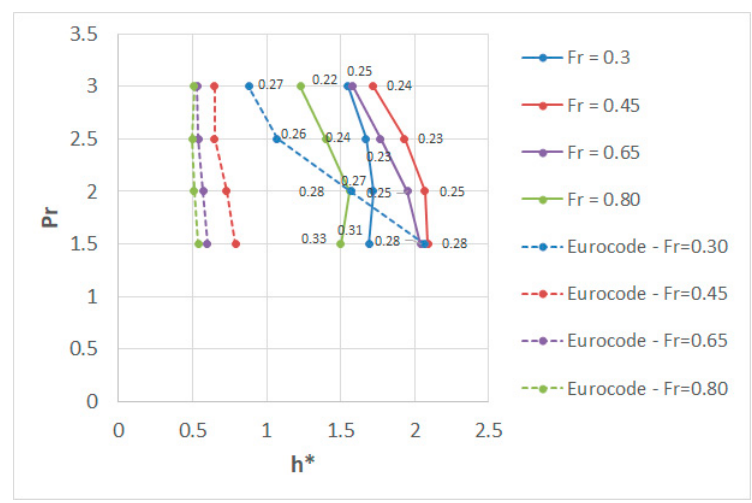
Figure 24. Comparison of contour lines of the threshold of deck failure between the Eurocode (C D = 1.44) [5] and this research for a box deck. Numbers on the figure demonstrate the blockage ratio (Br) for each failure point. To the right of each line is the unstable region, and the stable region is to the left. These stability curves hold for a comcrete box girder with a 48% void ratio, an aspect ratio (height:width) of 0.27, and a bearing friction coefficient of 0.25.